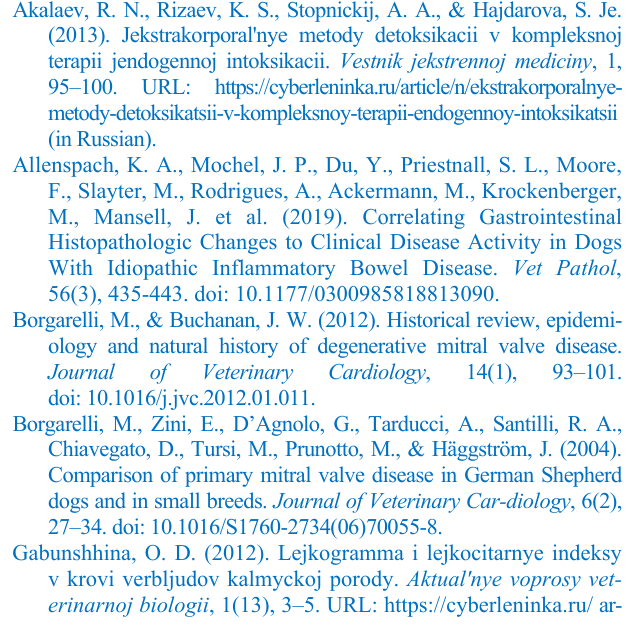
which includes algorithms for detecting and assessing the inflammatory process and endogenous intoxication in dogs, is effective, sensitive and fully reproducible in practice. 4. The developed technique allows the veterinarian to determine the state of the animal's body correctly, including pathological and initial pathological changes, as well as to assess the health level of the